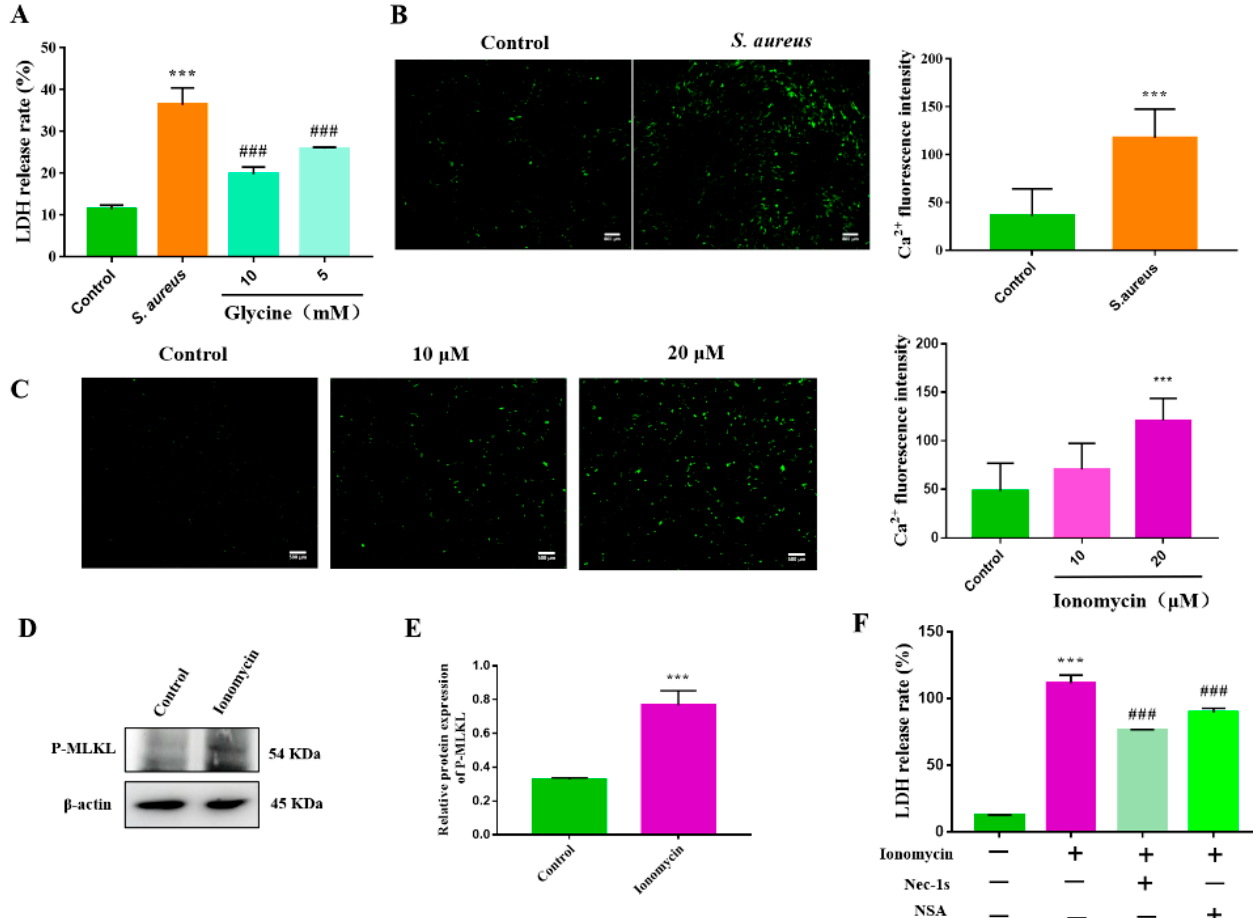
Figure 4. gEEC necroptosis was triggered by ion dysregulation and membranes disruption induced by S. aureus . ( A ) gEECs were pretreated with glycine for 2 h, then infected with 10 MOI S. aureus for 4 h. A CytoTox96 ® non-radioactive cytotoxicity assay kit was used to determine the cytotoxicity. ( B , C ) gEECs were infected with 10 MOI S. aureus for 4 h or treated with ionomycin for 4 h, followed by staining with Fluo-4 AM. The image was captured using a fluorescence microscope. Scale bar: 100 μ m. The Fluo-4 AM fluorescence intensity showed in right. ( D ) Western blot analysis of P-MLKL in ionomycin-treated gEECs. ( E ) Protein abundance of P-MLKL, normalized with β -actin. ( F ) gEECs were pretreated with a RIPK1 inhibitor (Nec-1s) or MLKL inhibitor (NSA) for 2 h, then treated with ionomycin for 4 h, followed by the cytotoxicity detection. *** p < 0.001 vs. control group, ### p < 0.001 vs . S. aureus group.